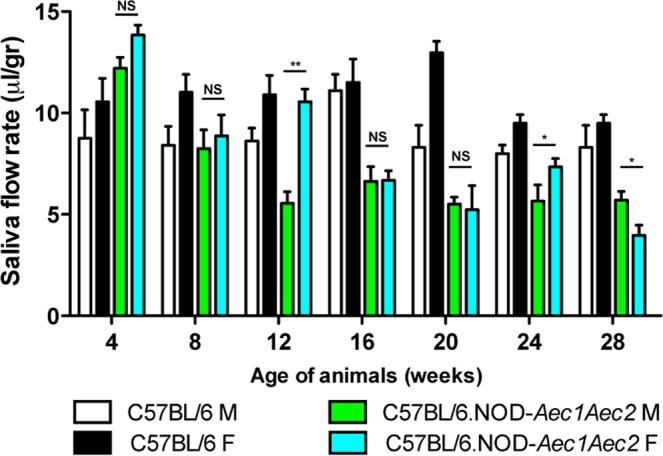
The onset of salivary secretory dysfunction. Saliva flows were collected as described in the Materials and Methods section. The data shown represent the mean saliva flow rate (volume/weight or μl/g)±s.e.m. per group (n=8, female C57BL/6, n=7 male C57BL/6, n=7 female C57BL/6.NOD-Aec1Aec2 female, n=8 male C57BL/6.NOD-Aec1Aec2). The statistical differences between male and female C57BL/6.NOD-Aec1Aec2 were determined using one-tailed Mann–Whitney tests at all threshold events. Error bars indicate s.e.m. with *P<0.05, **P<0.01, NS, no significant.